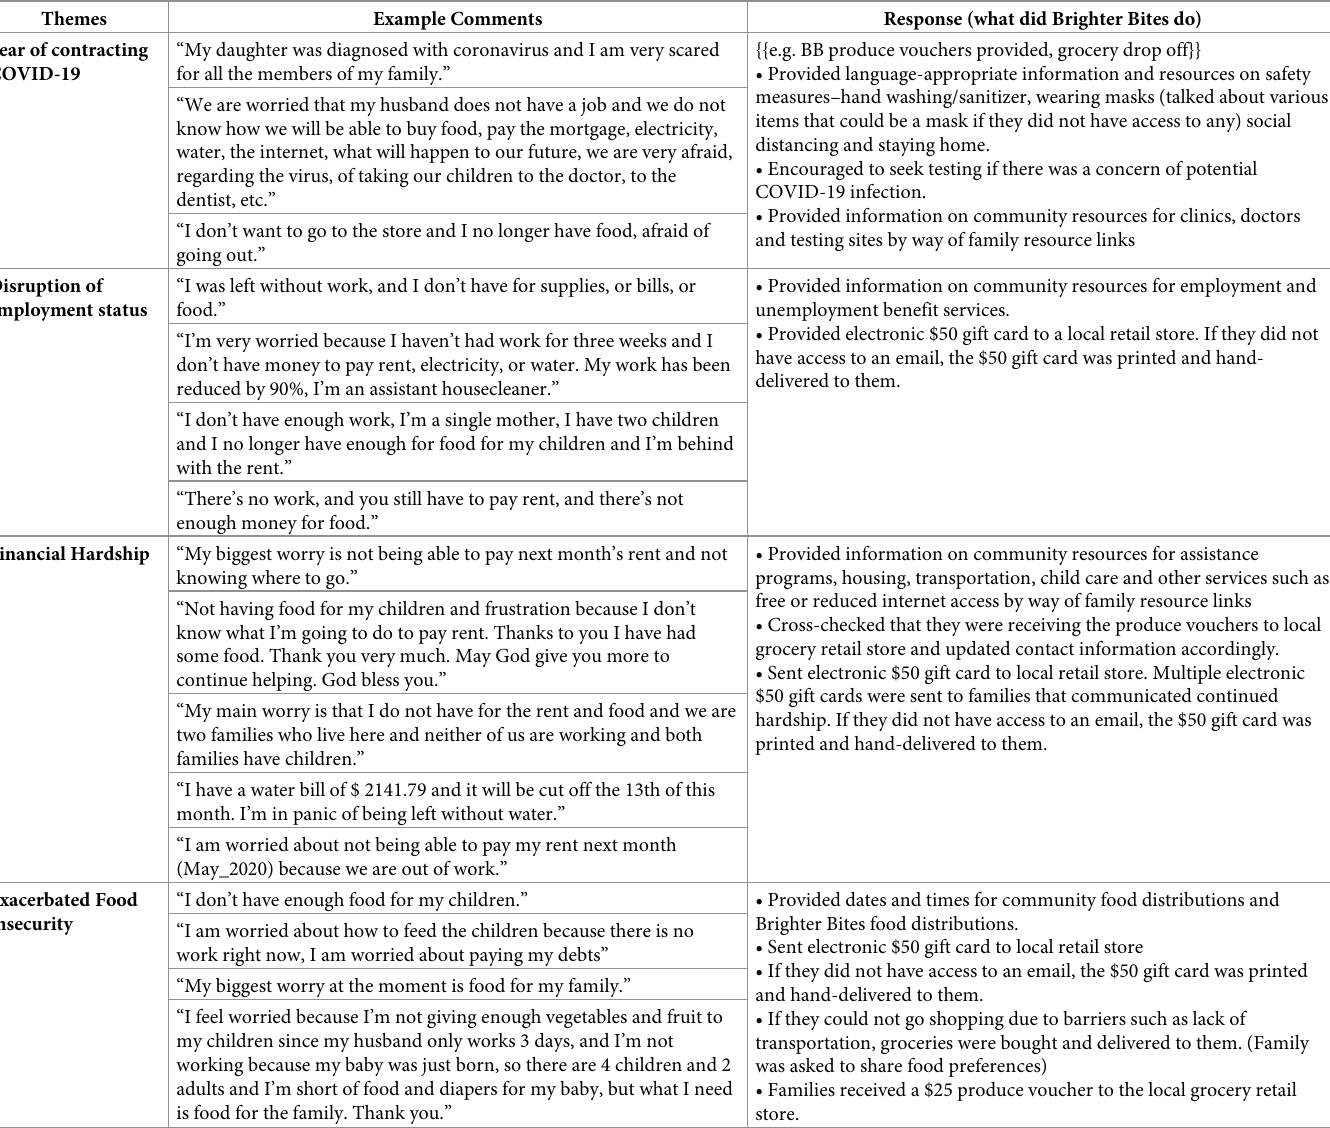
Table 2. Themes from qualitative triage assessment of the high-risk families (n = 71), Brighter Bites COVID-19 response